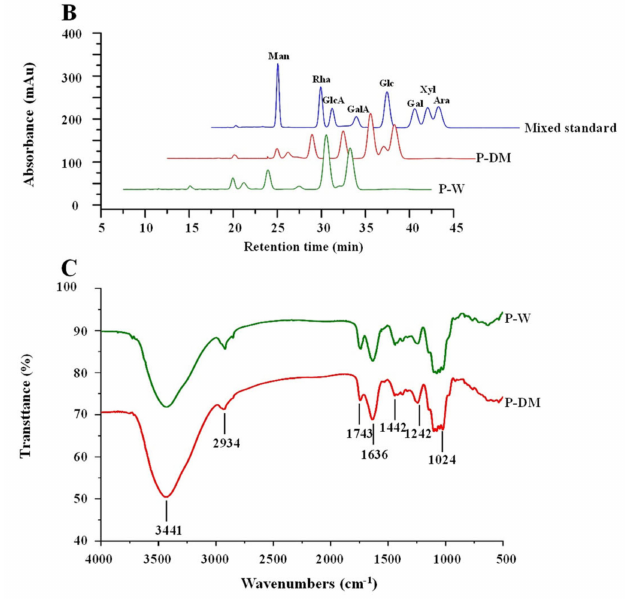
Figure 4. Size exclusion chromatograms ( A ), HPLC profiles of compositional monosaccharides ( B ), and FT-IR spectra ( C ) of polysaccharides extracted from sweet tea leaves. P-DM and P-W indicate polysaccharides extracted from sweet tea leaves by microwave-assisted deep eutectic solvent extraction and hot water extraction, respectively; Mixed standard, indicates GalA, Gal, Ara, Glc, Xyl, Rha, GlcA, and Man, which was analyzed by HPLC under the same conditions of